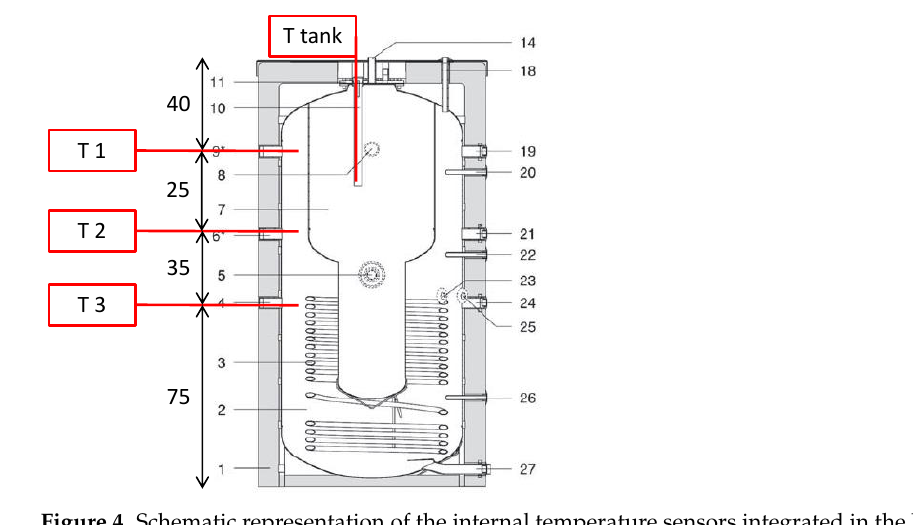
Figure 4. Schematic representation of the internal temperature sensors integrated in the hybrid TES system to monitor the process evolution.